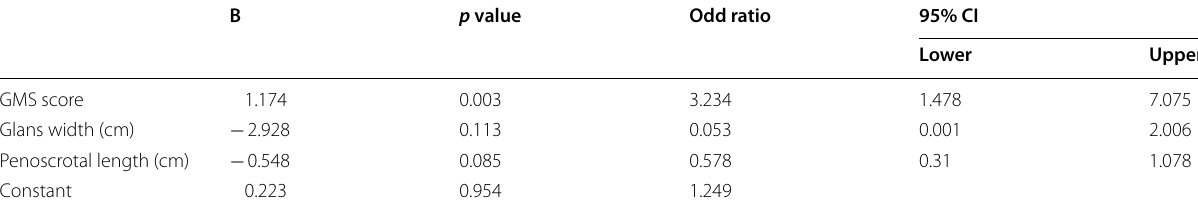
Table 4 Stepwise logistic regression table